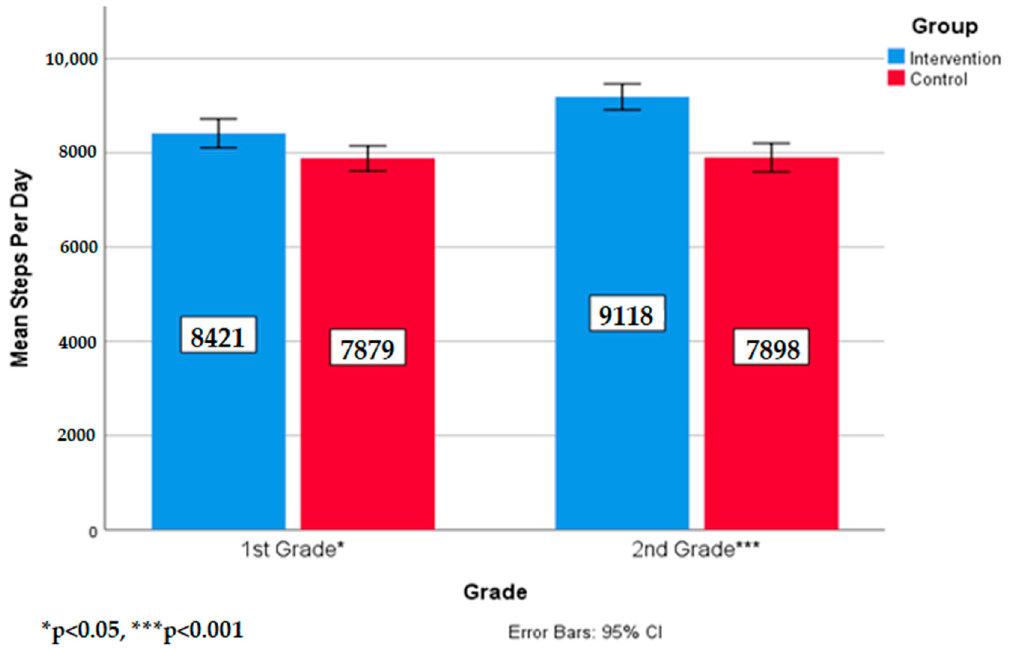
Figure 3. Means and standard deviations of steps per day by group by